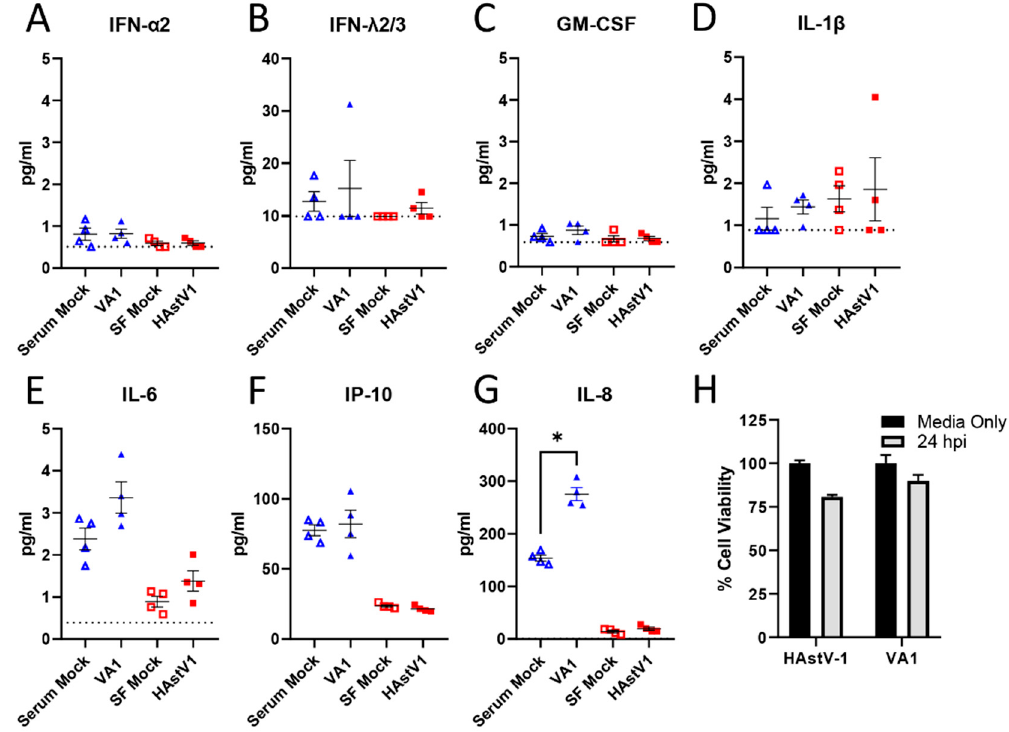
Figure 4. HAstV-1 and VA1 infection does not induce cytokines or cell death. A panel of 13 cytokines were analyzed from cell supernatants following 48 hpi for VA1 and serum-containing mock-infected wells and compared with supernatants from HAstV1 and serum free mock-infected wells 24 hpi. Levels of TNF- α , IL-12p70, IFN- β , IL-29, IL-10 and IFN- γ were all undetectable and are not shown. For the other 7 cytokines ( A – G ), the lower limit of detection is denoted by the dashed lines. Asterisks (*) denote statistical significance as measure by Mann Whitney U, with a cutoff value of p < 0.05. ( H ) Cell viability following VA1 and HAstV-1 infection at 24 hpi was measured using an ATP detection assay.